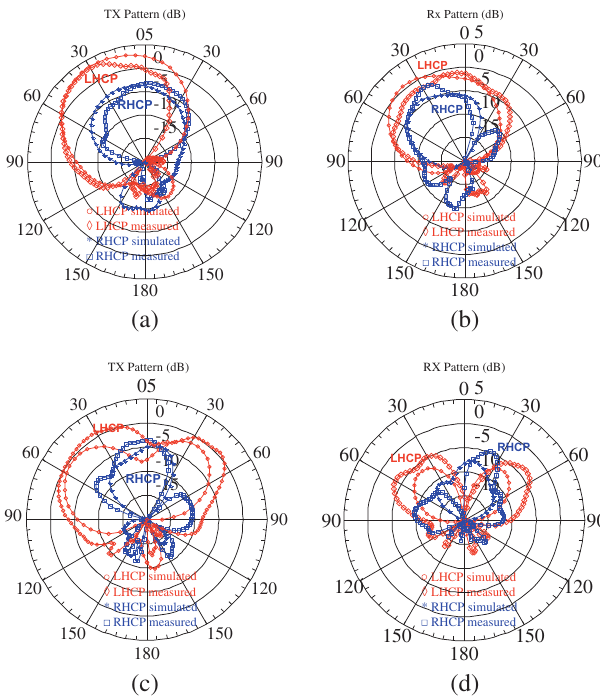
Figure 4. (a) Measured and simulated transmitting and (b) receiving antenna patterns (in the y-z plane) at 3.975 GHz, (c) Measured and simulated transmitting and (d) receiving antenna patterns (in the y-z plane) at 3.775